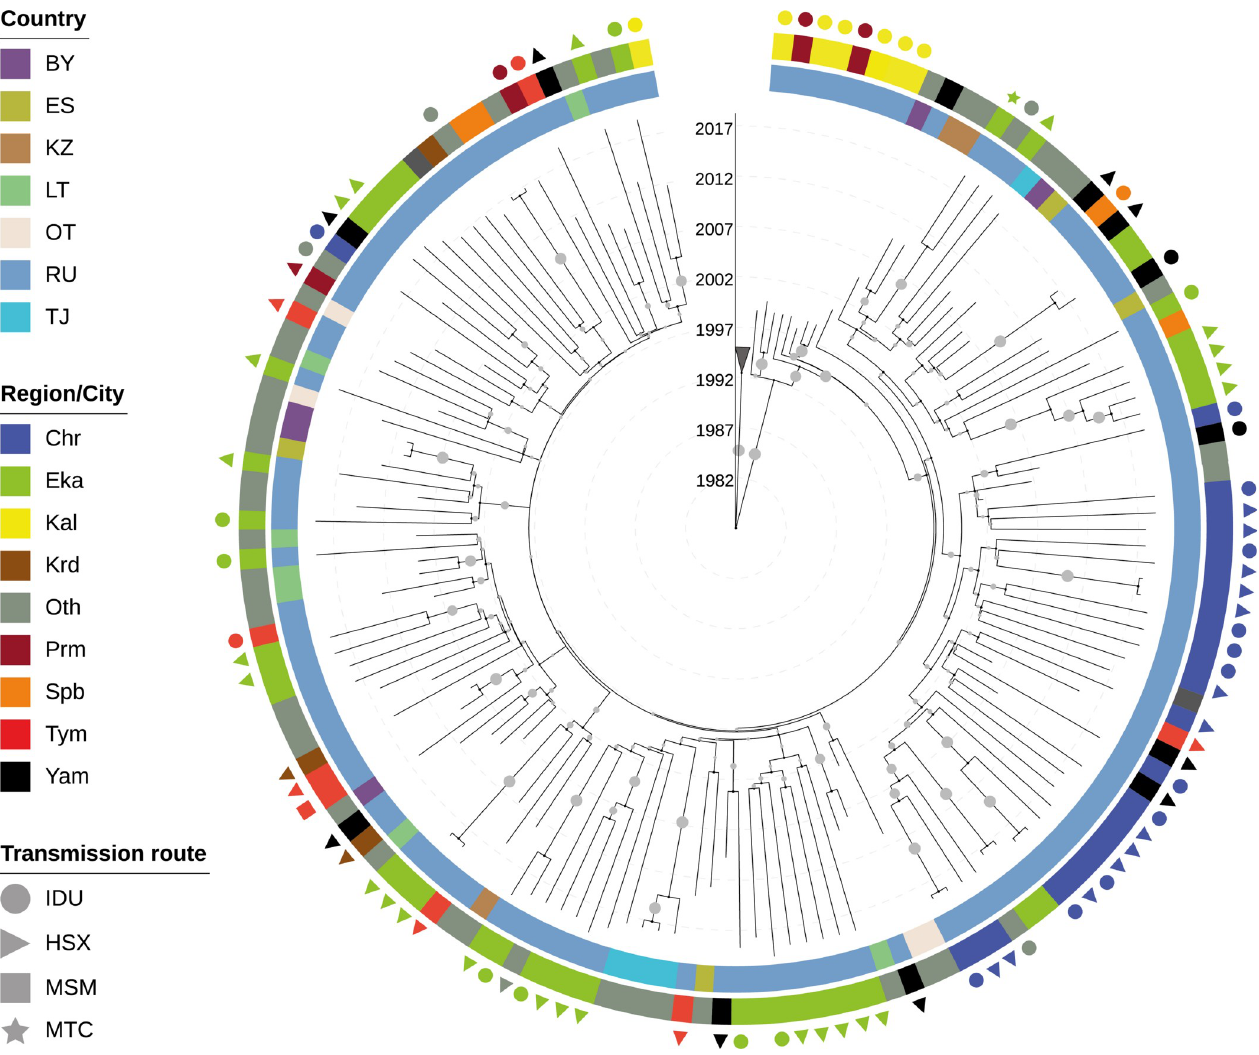
Fig 2. Bayesian time-scaled maximum clade credibility tree of 151 HIV-1 CRF03_AB recombinant pol sequences from former Soviet Union and neighboring states. Tree was rooted using FSU HIV-1 A6 sequences as outgroup (presented in collapsed form). The branch support (Posterior probability) is mapped with the circles using a grey color gradient/size (greater value, darker grey/greater circle). Concentric circles show the geographical regions of origin patient, symbols indicate the transmission route. Countries and separate cities (regions) are mapped on the inner and external concentric circle, receptively, using a color code as indicated in the legend. Branch lengths of Bayesian tree are drawn to scale with the concentric circles indicating calendar years. Abbreviation: BY, Belarus; ES, Spain; KZ, Kazakhstan; LT, Lithuania; OT, Other (countries with 2 or less available sequences; Table 1); RU, Russia; TJ, Tajikistan; Chr, Cherepovets; Eka, Ekaterinburg; Kal, Kaliningrad; Krs, Krasnodar; Oth, Other (cities with 2 or less available sequences; Table 1); Prm, Perm’; Spb, Saint-Petersburg; Tym, Tyumen’; Yam, Yamalo-Nenets Autonomous district; HSX, heterosexual contacts; IDU, injection drug users; MSM, men who have sex with men; MTC, mother-to-child